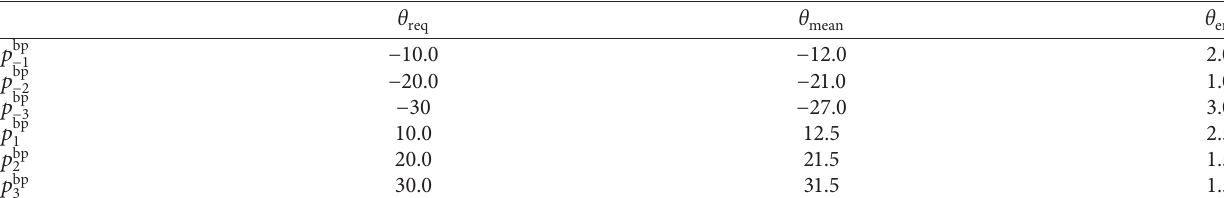
Table 4: Beam steering directions ( degrees )